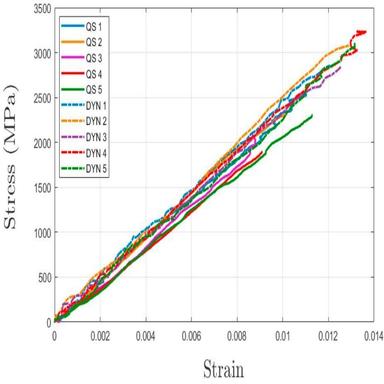
Stress-strain curves for the quasi-static (solid line) and dynamic (dashed line) compression experiments of AD85 alumina.